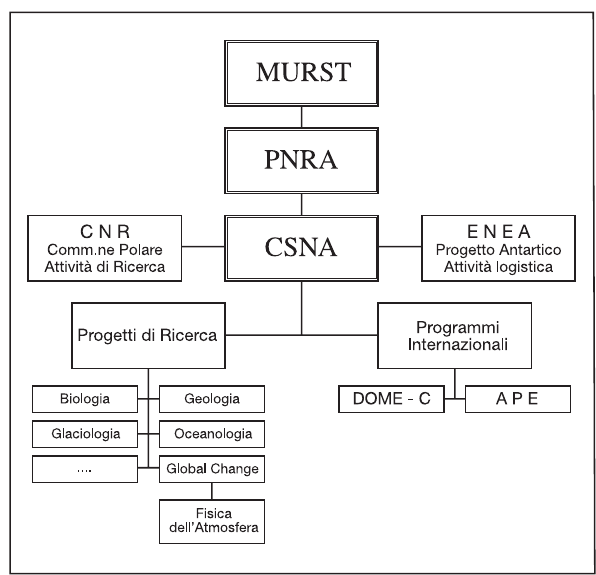
Fig. 2. Flow diagram of PNRA